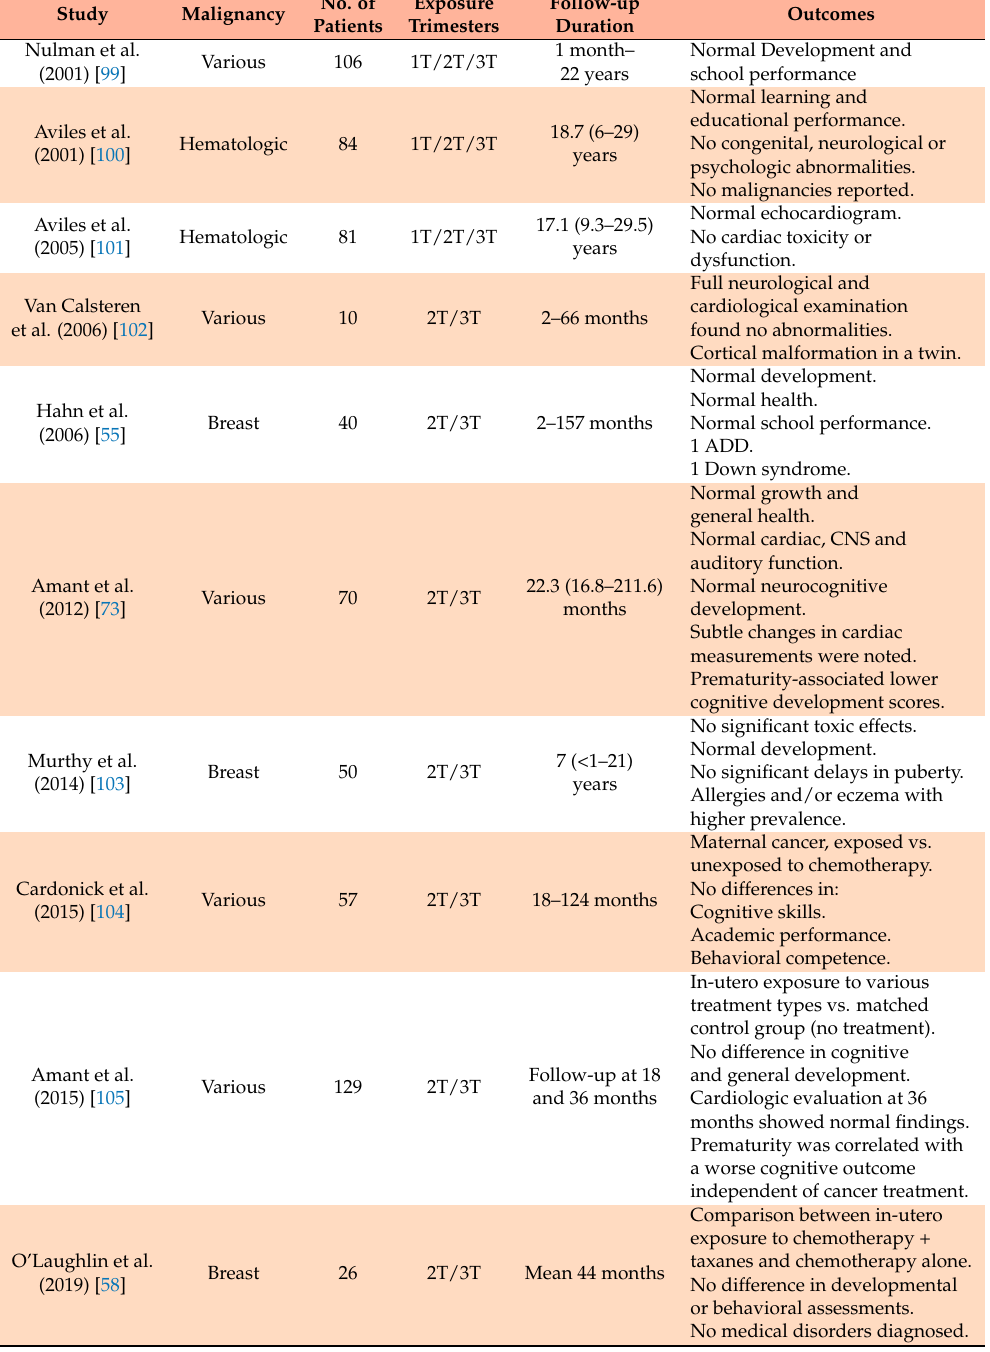
Table 1. Long-term neonatal outcomes following in-utero exposure to